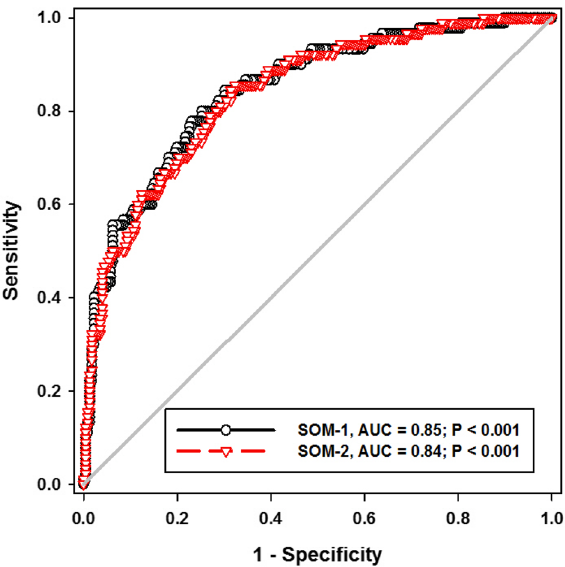
Figure 2. ROC curve for the proposed score of mortality (SOM) (SOM-1: score of mortality No-1, SOM-2: score of mortality No-2, AUC: area under curve, P considered significant if <